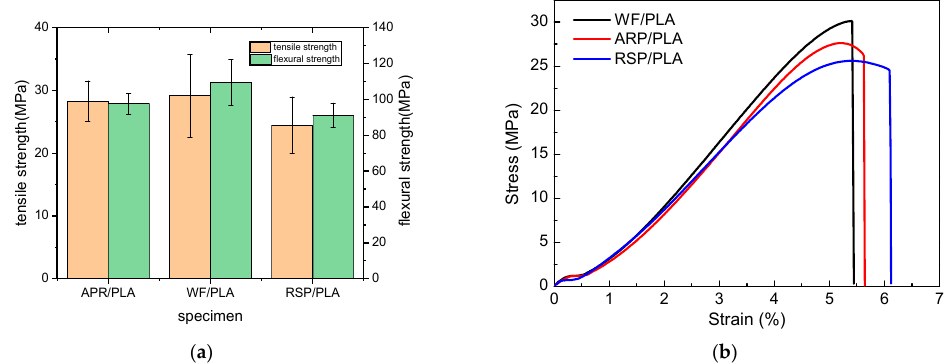
Figure 3. Mechanical properties of FDM 3D ‐ printed specimens ( a ) strength; and ( b ) δ – ε curve.